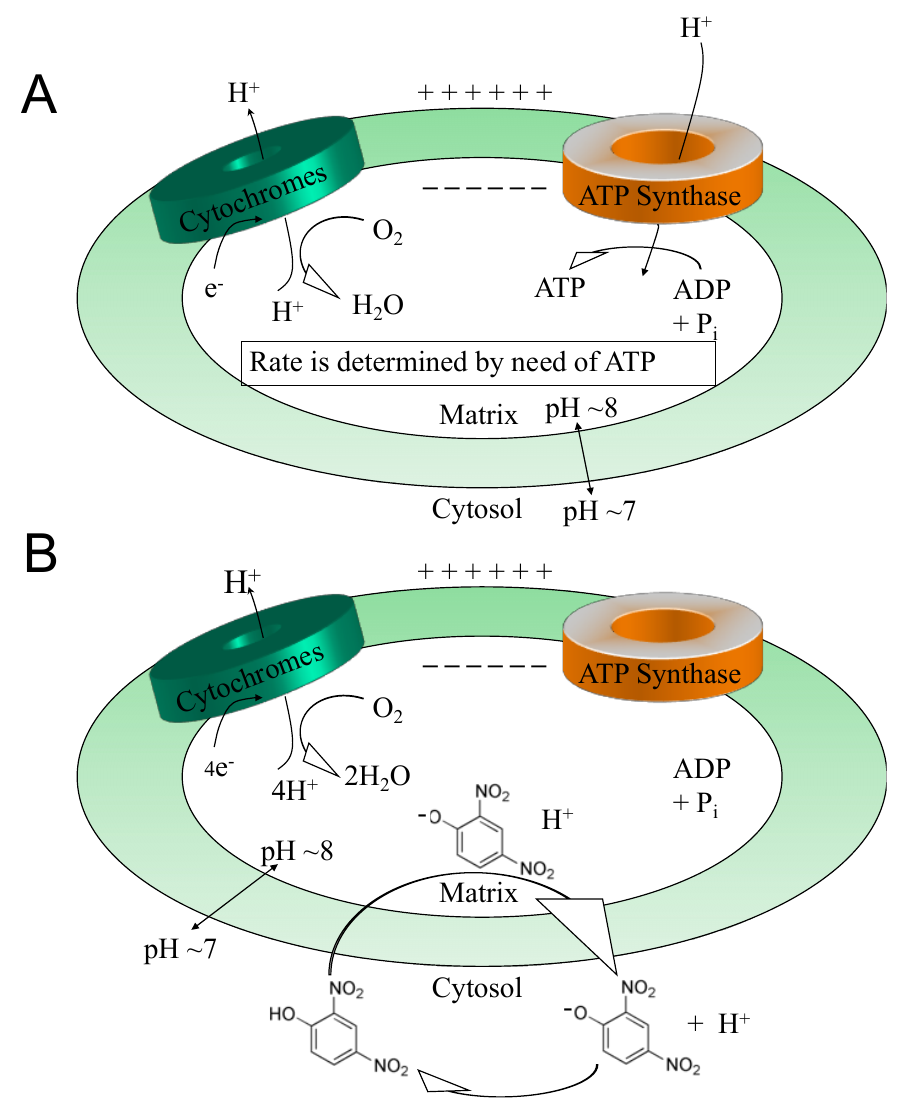
Figure 2. Coupling vs. uncoupling. Maintaining the proton gradient across the mitochondrial matrix and cytosol involves the pumping of protons out of the matrix via cytochromes I, III and IV. ( A ) The coupling of a proton (hydrogen or H + ) transfer to the synthesis of ATP is a result of H + returning through ATP synthase, causing rotation and subsequent phosphorylation of ADP, thereby yielding an ATP molecule. ( B ) This mechanism is circumvented in the case of chemical uncoupling (i.e., entry of protons without phosphorylation to produce ATP). The proton transfer into the matrix is on a carrier, a weak acid molecule (i.e., 2,4-dinitrophenol) with a unique dissociable proton (H + ) due to the two NO 2 “electron withdrawing” groups. Outside of the mitochondria in the acidic environment of the cytosol, DNP is in the protonated neutral form, but attracted to the basic environment of the matrix. Upon entering the matrix, DNP releases the dissociable proton (H + ). Now in the negatively charged anionic form, DNP is attracted to the acidic environment of the cytosolic space, therefore returning to the cytosol to become reprotonated and the cycle starts over again. All mitochondrial systems remain functional but are accelerated. Reprinted by permission from Springer, Diabetologia (2011) 54:237–244, Targeting Energy Expenditure via Fuel Switching and Beyond , J.G. Geisler [2].